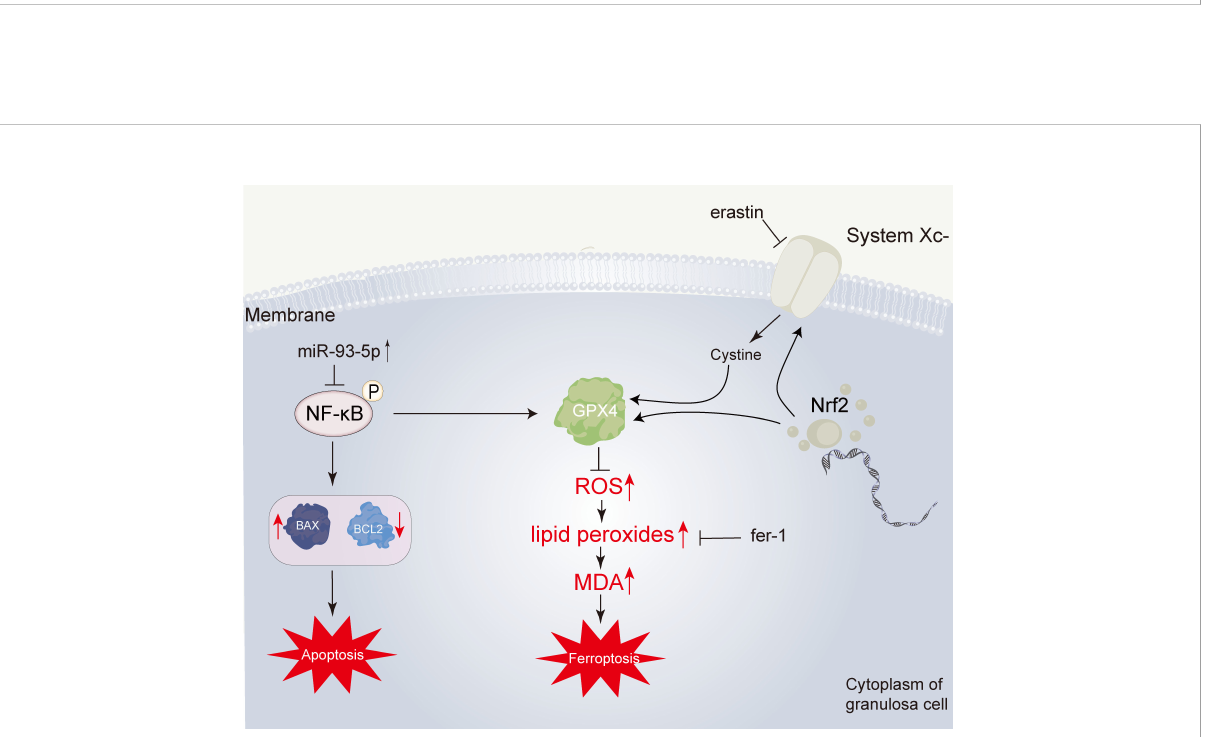
FIGURE 10 Overview of the effect of miR-93-5p in GC. The miR-93-5p is elevated in PCOS. The elevated miR-93-5p negatively regulates the NF- k B signaling pathway, inducing the increase of BAX and the decrease of BCL2, and fi nally leading the cell apoptosis. Additionally, when the NF- k B signaling pathway is inhibited, the transcription of GPX4 is declined. Then, the level of lipid peroxides is promoted. This process can be inhibited by ferrostatin-1 (fer-1). Lipid peroxides can be degraded into reactive aldehydes, such as malondialdehyde